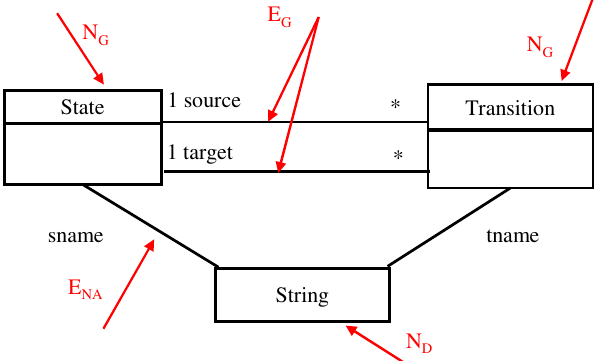
Figure 11. An E-Graph, EG, with node attributes represented as edges. The star (*) indicates that zero or more instances of the class “Transition” are associated with one instance of the class